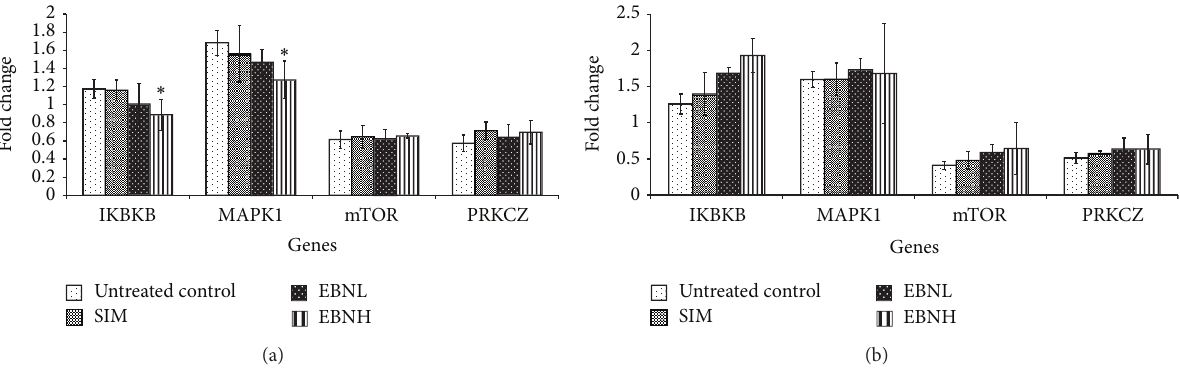
Figure 6: Effects of edible bird’s nest (EBN) on (a) hepatic and (b) adipose tissue mRNA levels of mammalian target of rapamycin (mTOR), protein kinase C zeta (Prkcz), inhibitor of kappa light polypeptide gene enhancer in B-cells, kinase beta (IKBKB), and mitogen-activated protein kinase (MAPK) 1 in high fat diet- (HFD-) fed rats. Groupings are similar to Figure 2. ∗ indicates significant difference ( 𝑃 < 0.05 ) in comparison with untreated